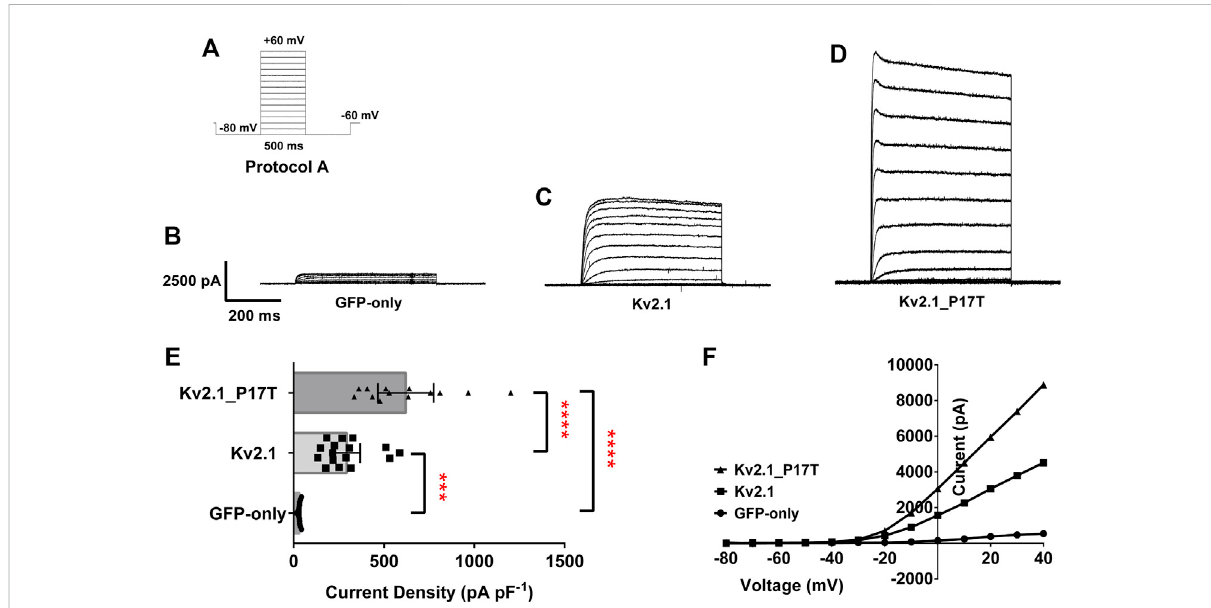
FIGURE 2 K V 2.1 mutation, P17T is a gain of function mutation. (A) Schematic representation of voltage protocol A. tsA201 cells were held at − 60 mV, stepped down to − 80 mV for 500 m and then from − 80 to +60 mV in 10 mV steps for 500 m, followed by a step back down to − 80 mV for 500 m, then back to − 60 mV. One sweep was recorded every 15 s, for 15 sweeps. (B) Average whole-cell current trace recorded using protocol A when expressing GFP-only. (C) Average whole-cell current trace recorded using protocol A when expressing K V 2.1-WT. (D) Average